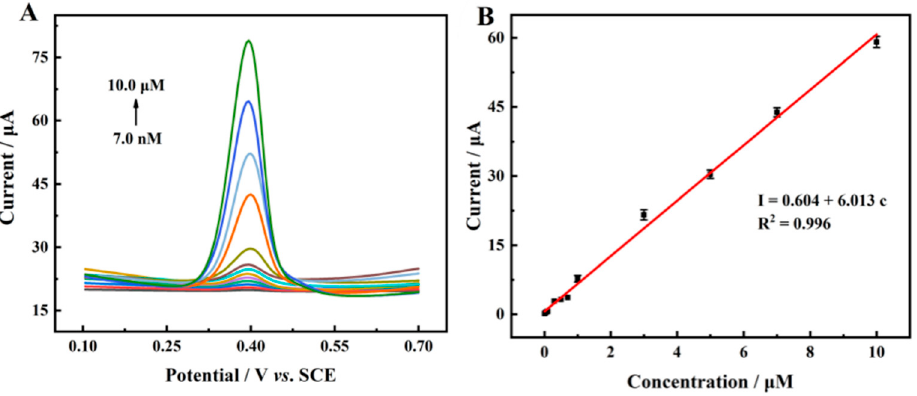
Figure 8. ( A ) DPVs of 0.007, 0.03, 0.05, 0.08, 0.1, 0.3, 0.5, 0.7, 1.0, 3.0, 5.0, 7.0 and 10.0 µ M baicalein on TiO 2 -MXene/PEDOT:PSS/GCE in 0.1 M PB (pH 2.0); ( B ) Linear curve of oxidation peak current vs. concentration.